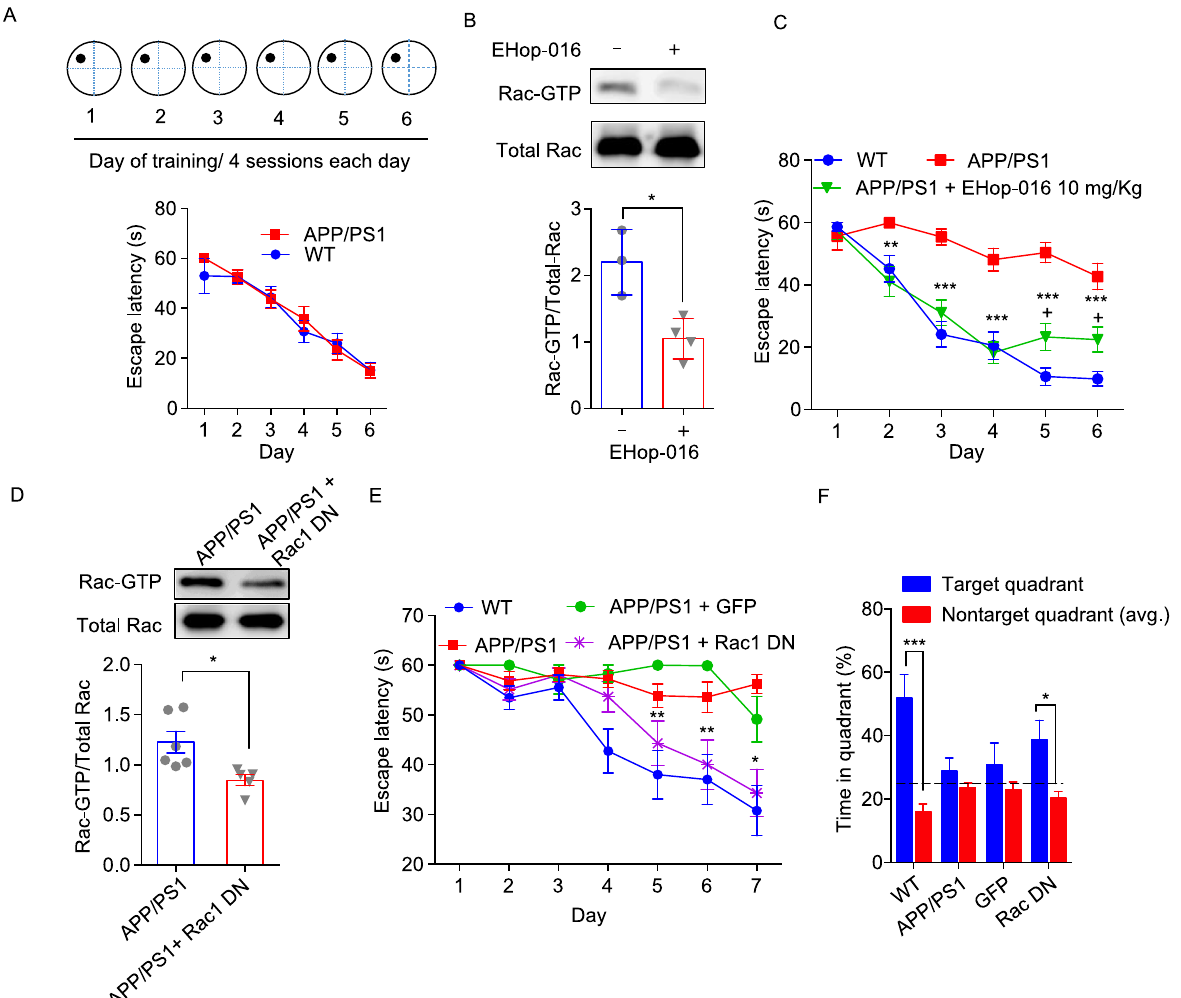
Figure 2. The ameliorating effect of Rac1 activity inhibition on the learning defects associated with APP/PS1. (A) No learning de fi cits were observed in the young (3-month-old) APP/PS1 mice in comparison with age-matched WT mice in the Morris Water Maze (MWM) assay. The training paradigm (upper panel); escape latency curve during the MWM task (lower panel) ( P > 0.05, two-way ANOVA followed by Sidak ’ s multiple comparison test; n = 7 per group). (B) Western blot of EHop-016 showed inhibition of Rac1 activity in the hippocampal tissues of 9-month-old AD mice. Comparison of Rac1 activity in hippocampal tissues after administration of EHop-016 (10 mg/kg) for 10 days (** P < 0.01, *** P < 0.0001, t -test, two-tailed; n = 3 for the EHop-016(-) control group, n = 4 for the EHop-016(+) treatment group). (C) Administration of Rac1 activity inhibitor (EHop-016) mitigated the learning de fi cit in 9-month-old APP/PS1 mice. Both WT control group (blue line) and APP/PS1 control group (red line) received the same volume of vehicle throughout the assay. Escape latency curve during the MWM (+ P < 0.05, two-way ANOVA followed by Tukey ’ s multiple comparison test, treatment effect, APP/PS1 control versus APP/PS1 + EHop-016; ** P < 0.01, *** P < 0.0001, two-way ANOVA followed by Tukey ’ s multiple comparison test; n = 7 per group, genotype effect, WT control versus APP/PS1 + EHop-016). (D) Rac1 activity was signi fi cantly suppressed in hippocampal tissues after injection of rAAV-CaMKII α -Rac1 DN or PBS (* P < 0.05, t -test, two-tailed; n = 5 per group). (E) Escape latency curve during the MWM task. Genetic manipulation of Rac1 activity in the hippocampus by the speci fi c expression of dominant negative Rac1 (Rac1 DN) in 12-month-old APP/PS1 mice with rescued learning defect. Both the WTcontrol group (blue line) and APP/PS1 control group (red line) underwent sham surgeries (* P < 0.05, ** P < 0.01, two-way ANOVA followed by Tukey ’ s multiple comparison test; n = 7 per group). (F) Percentage of time spent in the target quadrant during the probe test. GFP: APP/PS1 + GFP; Rac1 DN: APP/PS1 + Rac1 DN (* P < 0.05, *** P < 0.0001, t -test, two-tailed, same mice as in (E)). Data information: All values are expressed as mean ±